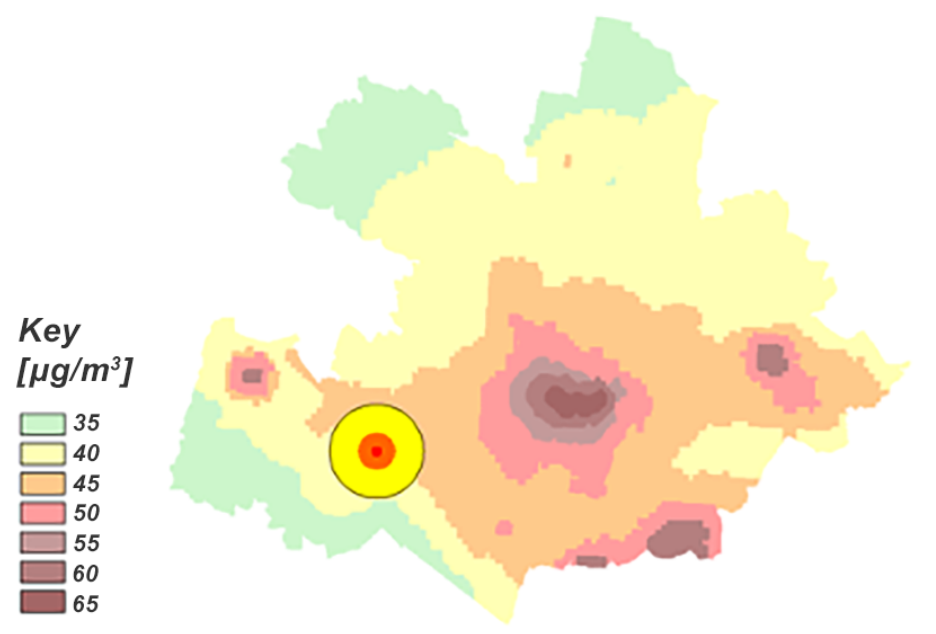
Figure 5. Optimal location of the source of pollution with the range of the plume